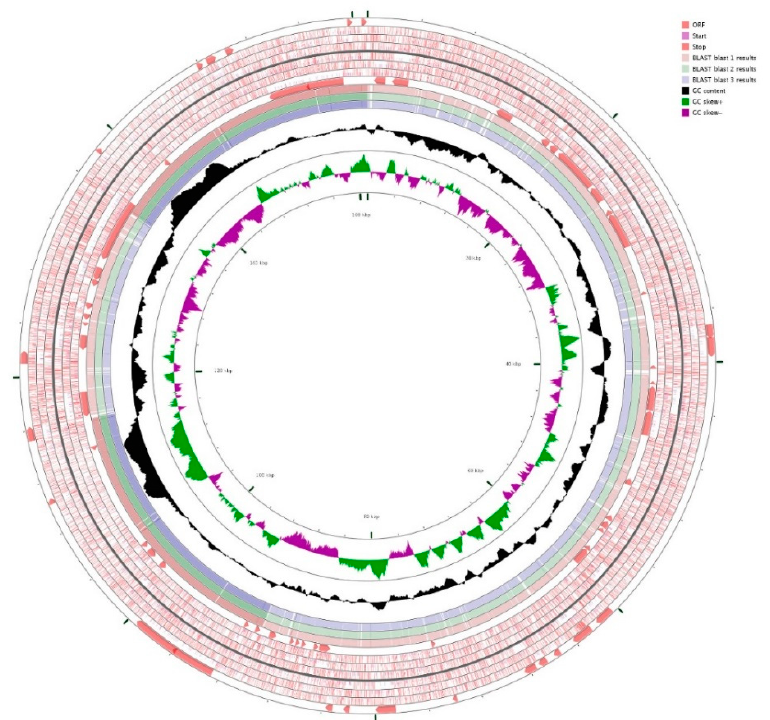
Figure A1. BLAST result of the chloroplast genome and the GC stew of Q. acutissima. BlAST 1 represents L. balansae ; BlAST 2 represents Q. variabilis ; BlAST 3 represents Q. dolicholepis .